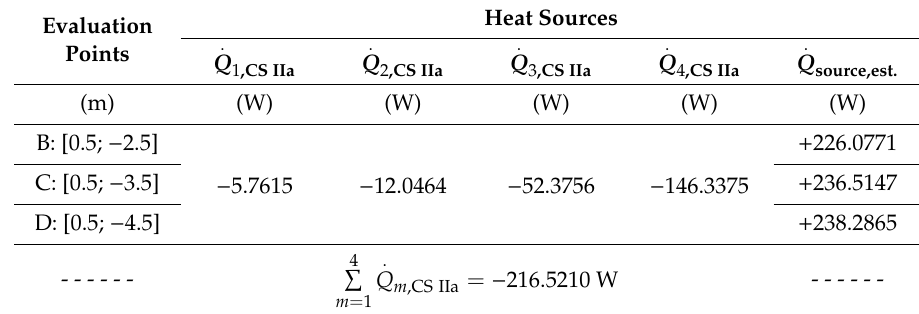
(cid:110) (cid:111) = { 200, 100, 250 } x 0 , x lower , x upper